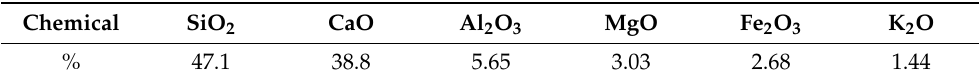
Table 2. Chemical composition of